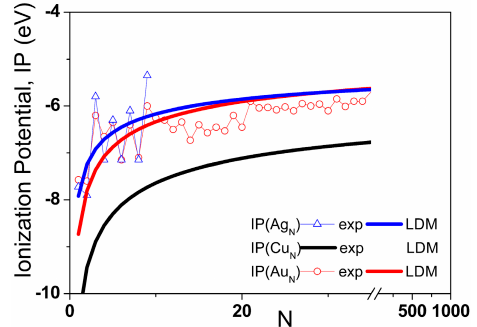
Figure 2. Compilation of Experimental values of the ionization potential of Cu N [9], Ag N